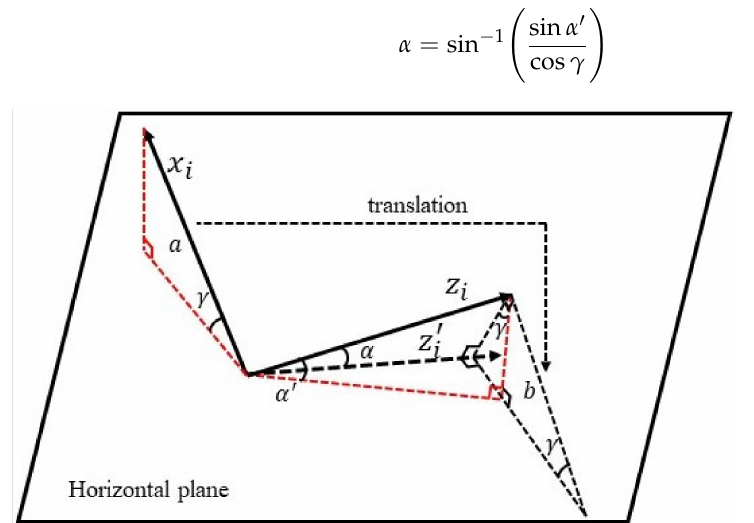
Figure 4. Geometric relationship between the measured angle and rotation